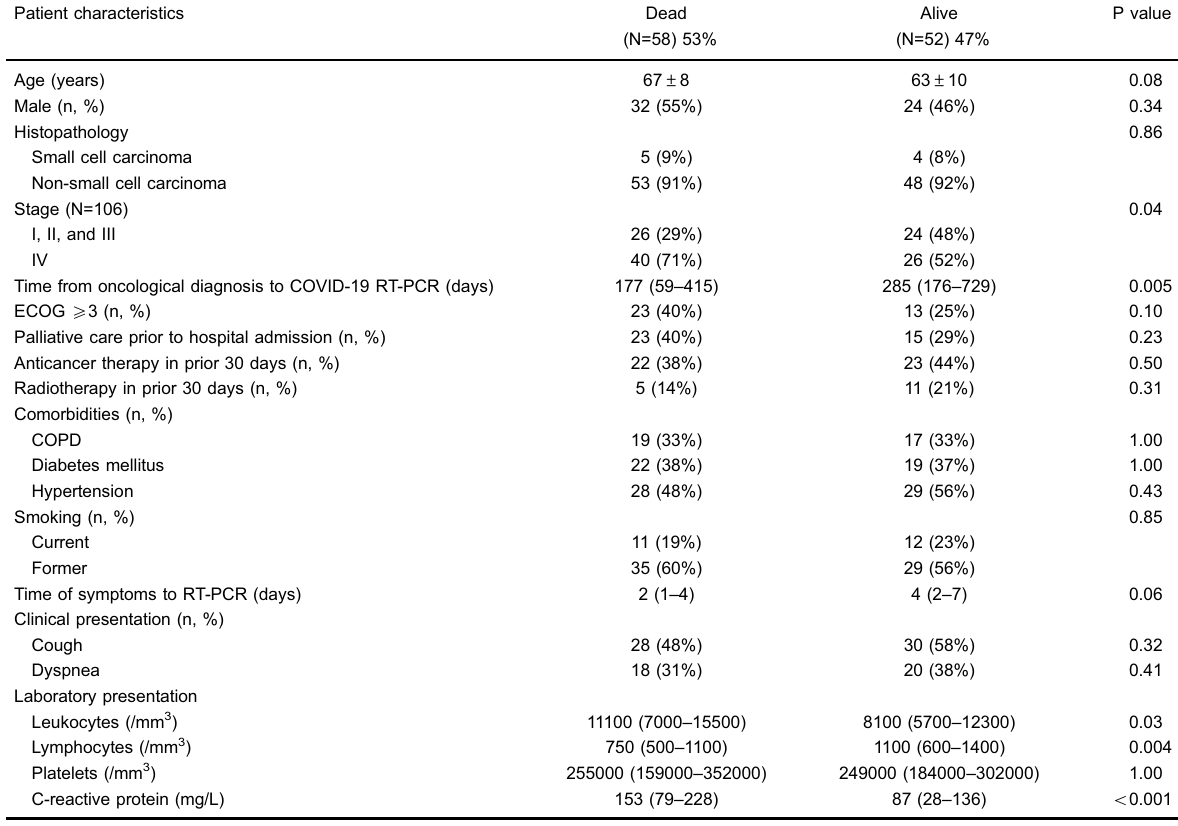
Table 2. Clinical characteristic according to death